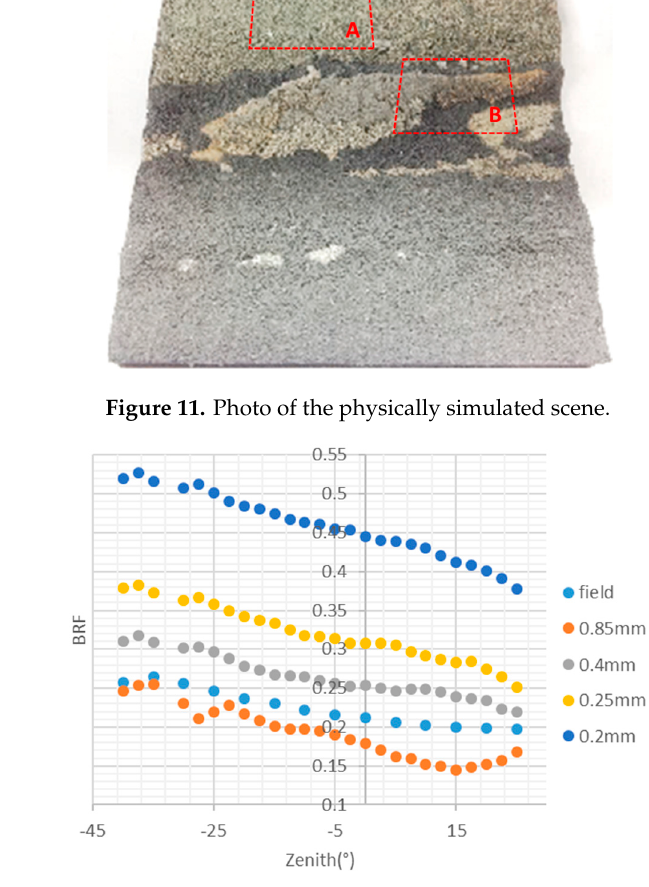
Figure 12. BRF of smashed rock samples of different diameters.